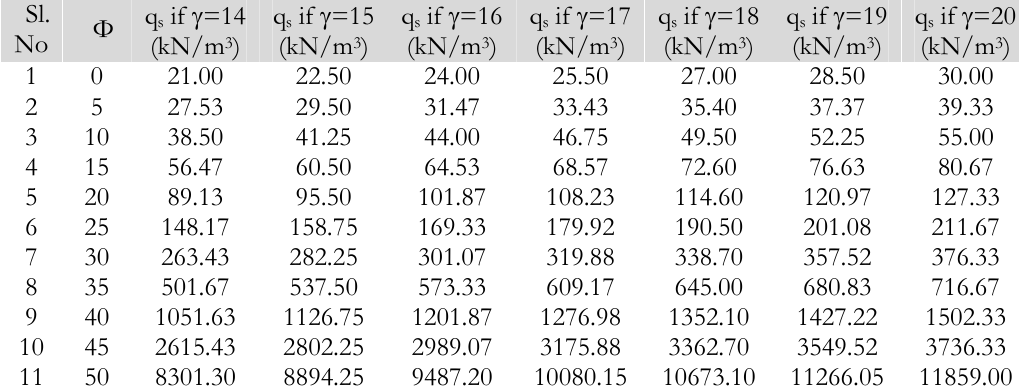
Table 2: Safe bearing capacity of soil when soil density (  ) is varied, cohesion is zero and width and depth of foundation are equal to 1.5 and 2.5 m, respectively.